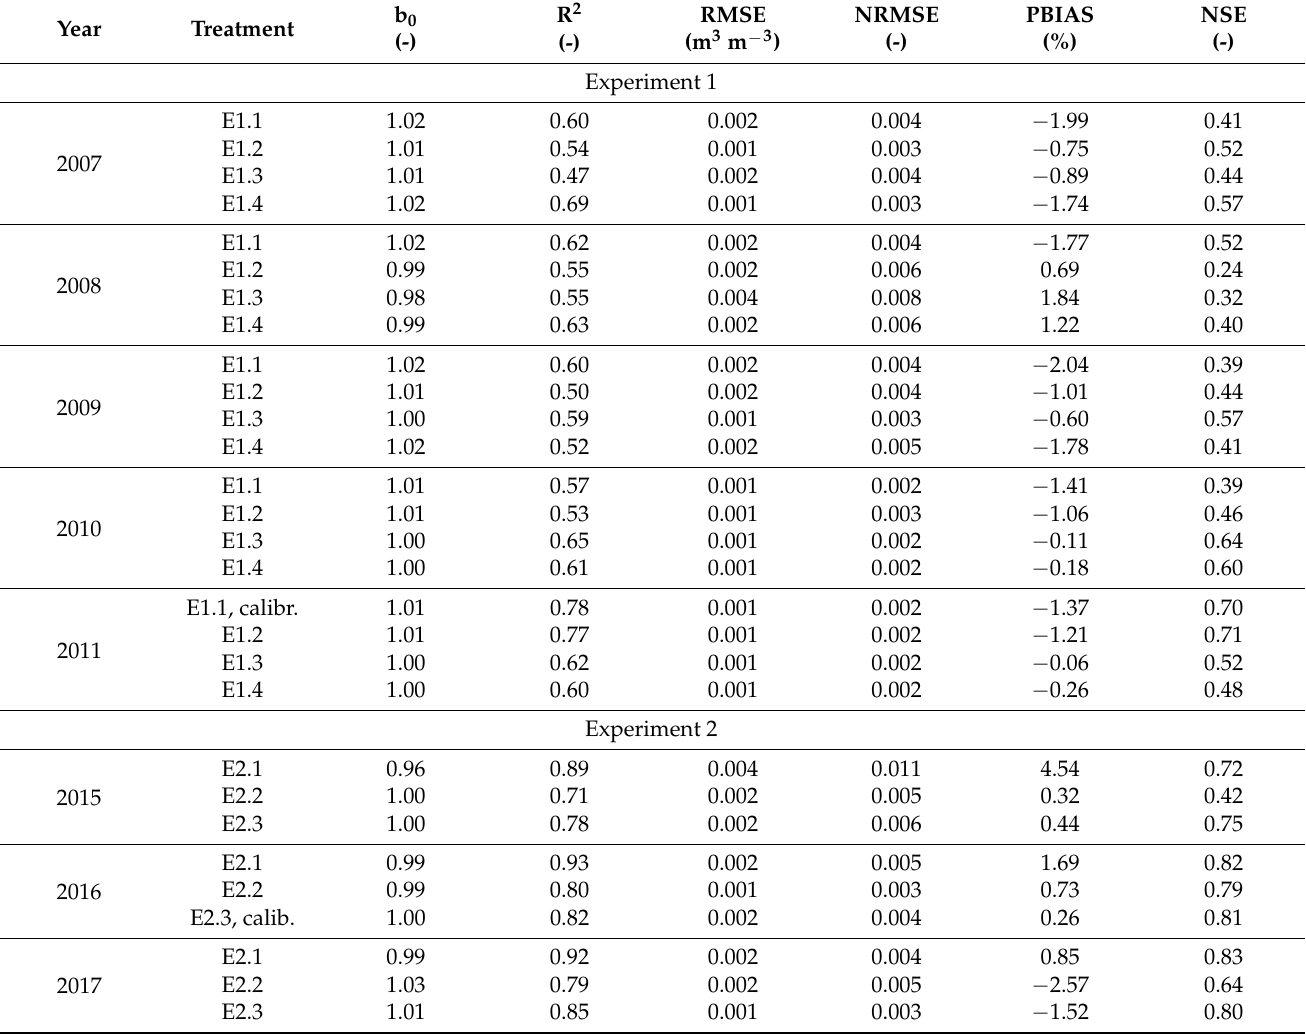
Table 8. Goodness-of-fit indicators for the adjustment between measured and simulated